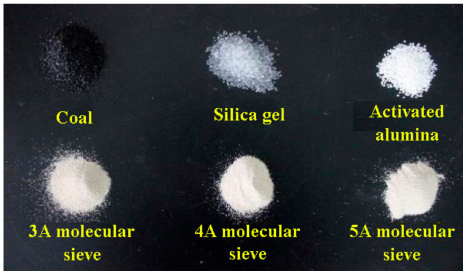
Figure 1. Testing materials selected in the experiment: coal, silica gel, activated alumina, the 3Å molecular sieve, 4Å molecular sieve and 5Å molecular